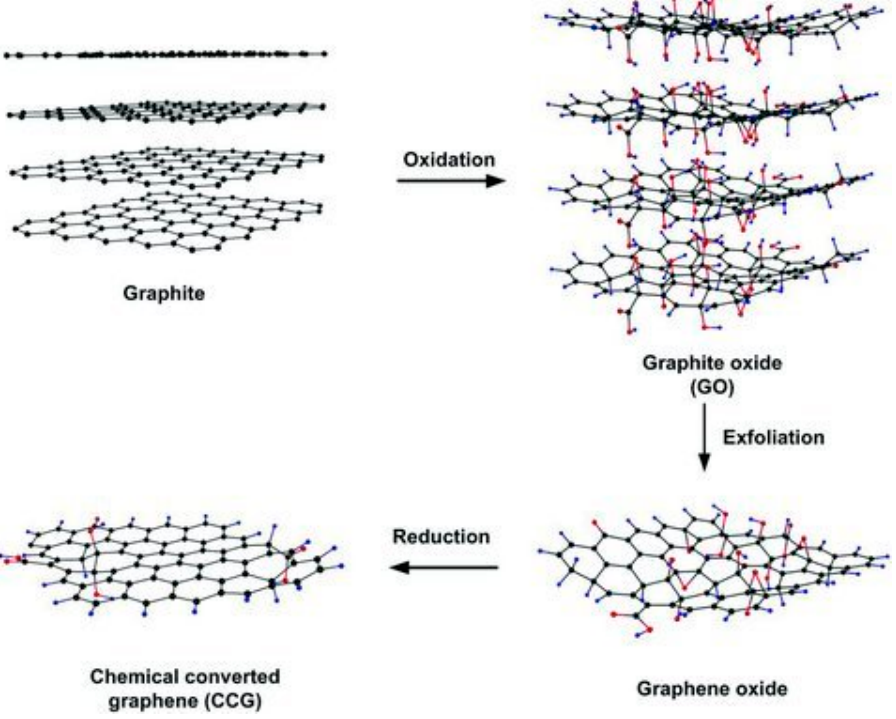
Figure 1. Preparation of graphene nanosheets from graphite. Reproduced with permission from [37], John Wiley and Sons, 2011.